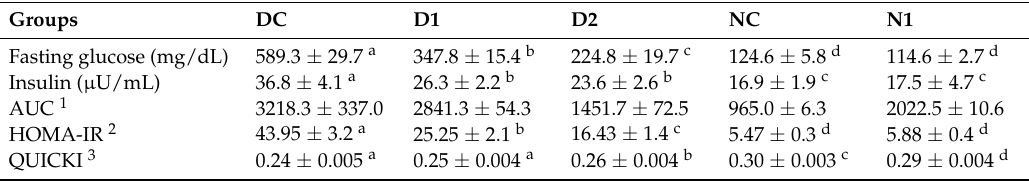
Figure 5. Effect of OFS on blood glucose levels during experimental period ( A ) and oral glucose tolerance ( B ) in db/db mice. Normal db/- mice control (NC); normal db/- mice fed 1 g/kg body weight of OFS (N1); db/db mice control (DC); db/db mice fed 1 g/kg body weight of OFS (D1); db/db mice fed 2 g/kg body weight of OFS (D2). For glucose tolerance tests, mice were given glucose (2 g/kg body weight). Data are expressed as means ± SE ( n = 8). Bars not sharing a common letter are significantly different at p < 0.05. Table 1. Effects of OFS on glycemic index parameters.